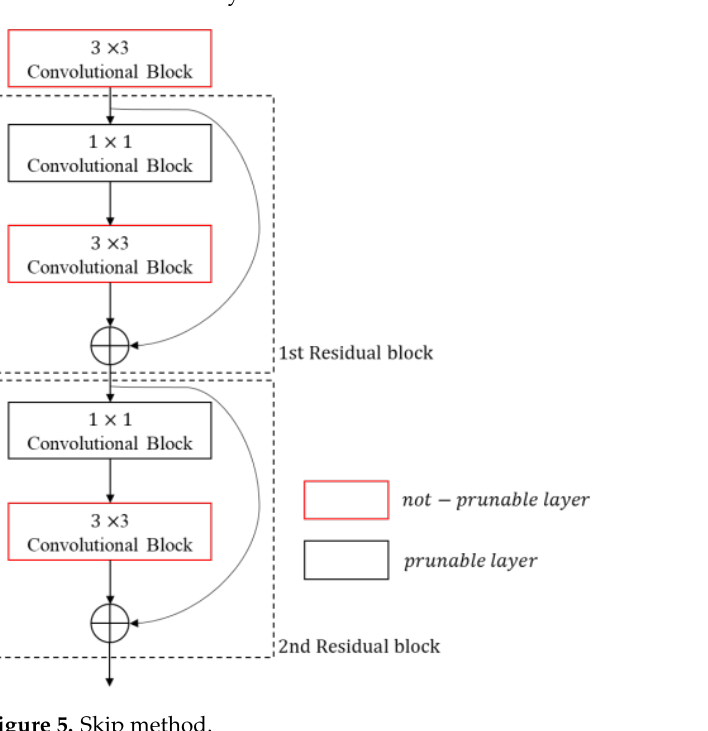
Figure 5. Skip method.